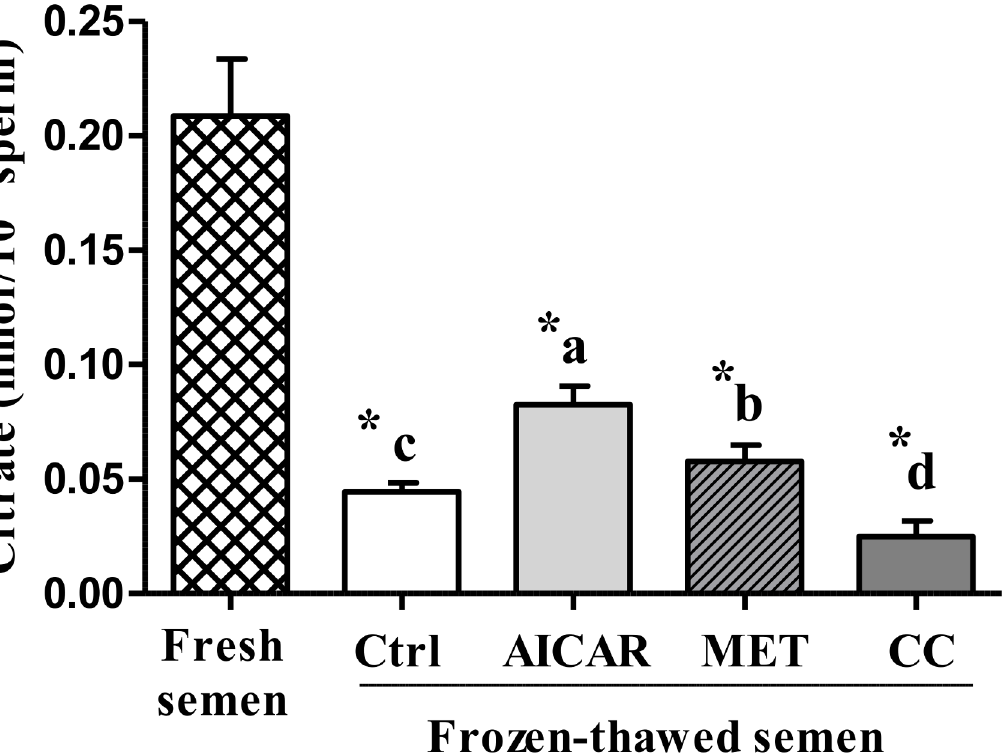
Fig 6. Effect of AMPK modulators (AICAR, MET and CC) on frozen-thawed sperm citrate level. Sperm were treated in the presence of an AMPK activator (2mM AICAR (in light gray) or 1mM MET (in diagonals)) or an AMPK inhibitor (5 μ M CC (in dark gray)) or Control (Ctrl, in white); Fresh semen (checkered pattern). Values represent means ± SEM from 6 different experiments (4 samples/experiment). Different superscripts indicate significant differences between Ctrl and treatments (AICAR, MET or CC) in frozen-thawed semen ( a,b,c,d , P < 0.05). Asterisks indicate statistically significant differences between fresh and frozen-thawed semen ( * , P < 0.001).